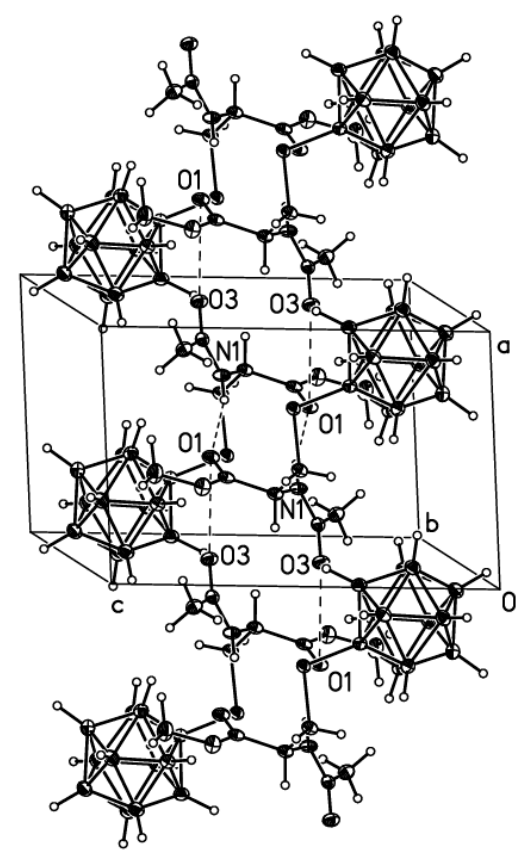
Figure 4. A fragment of the infinite chain formed in crystal of 8 along the a axis. Non-hydrogen atoms are given as probability ellipsoids of atomic displacements ( p = 0.5).